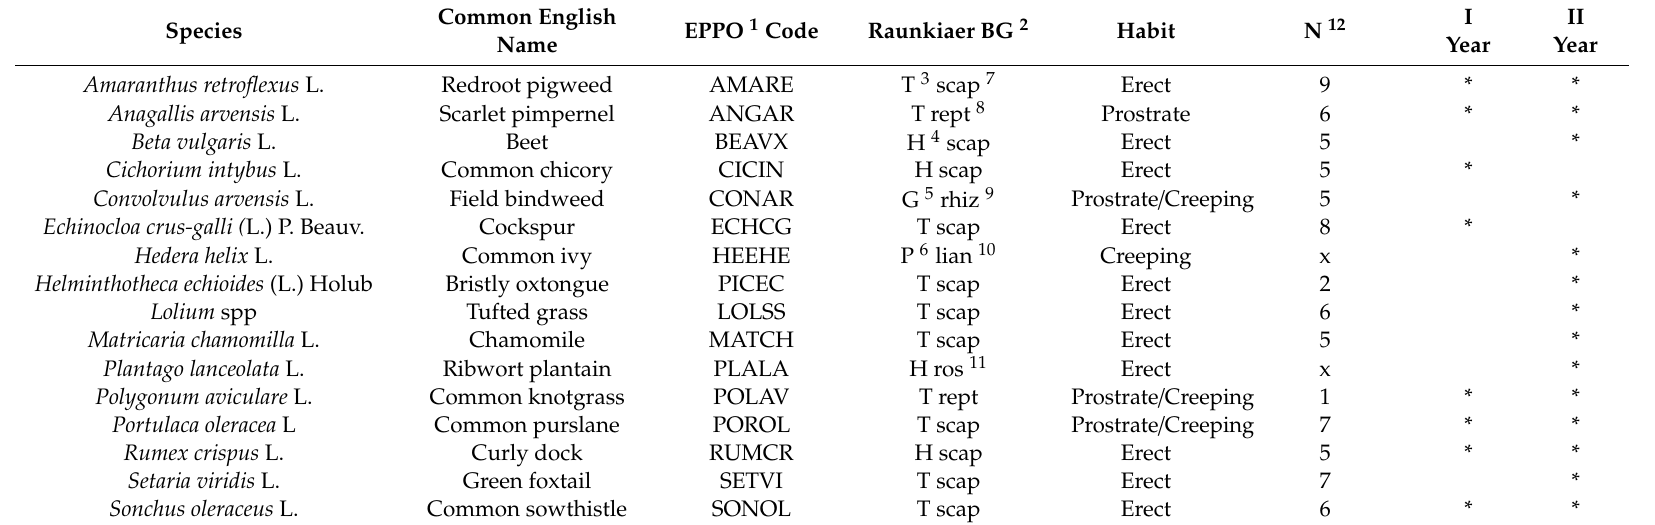
Table 3. Ecological characterization of weed communities